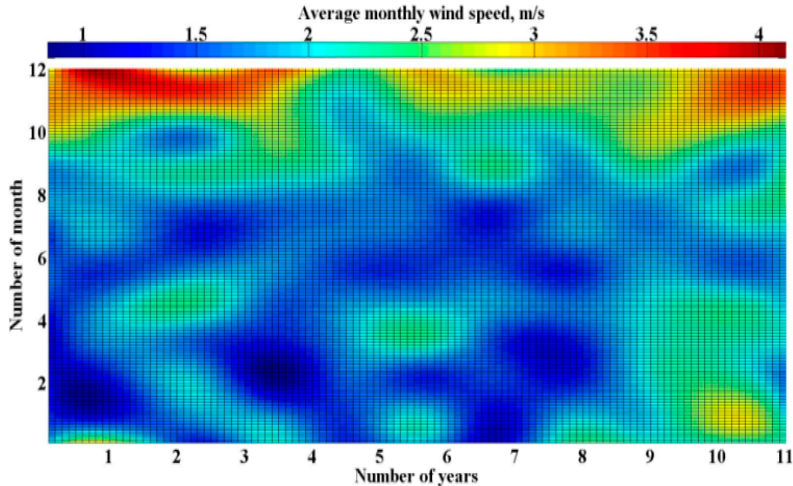
Figure 7. Wind speed records for the selected location for 11 years.